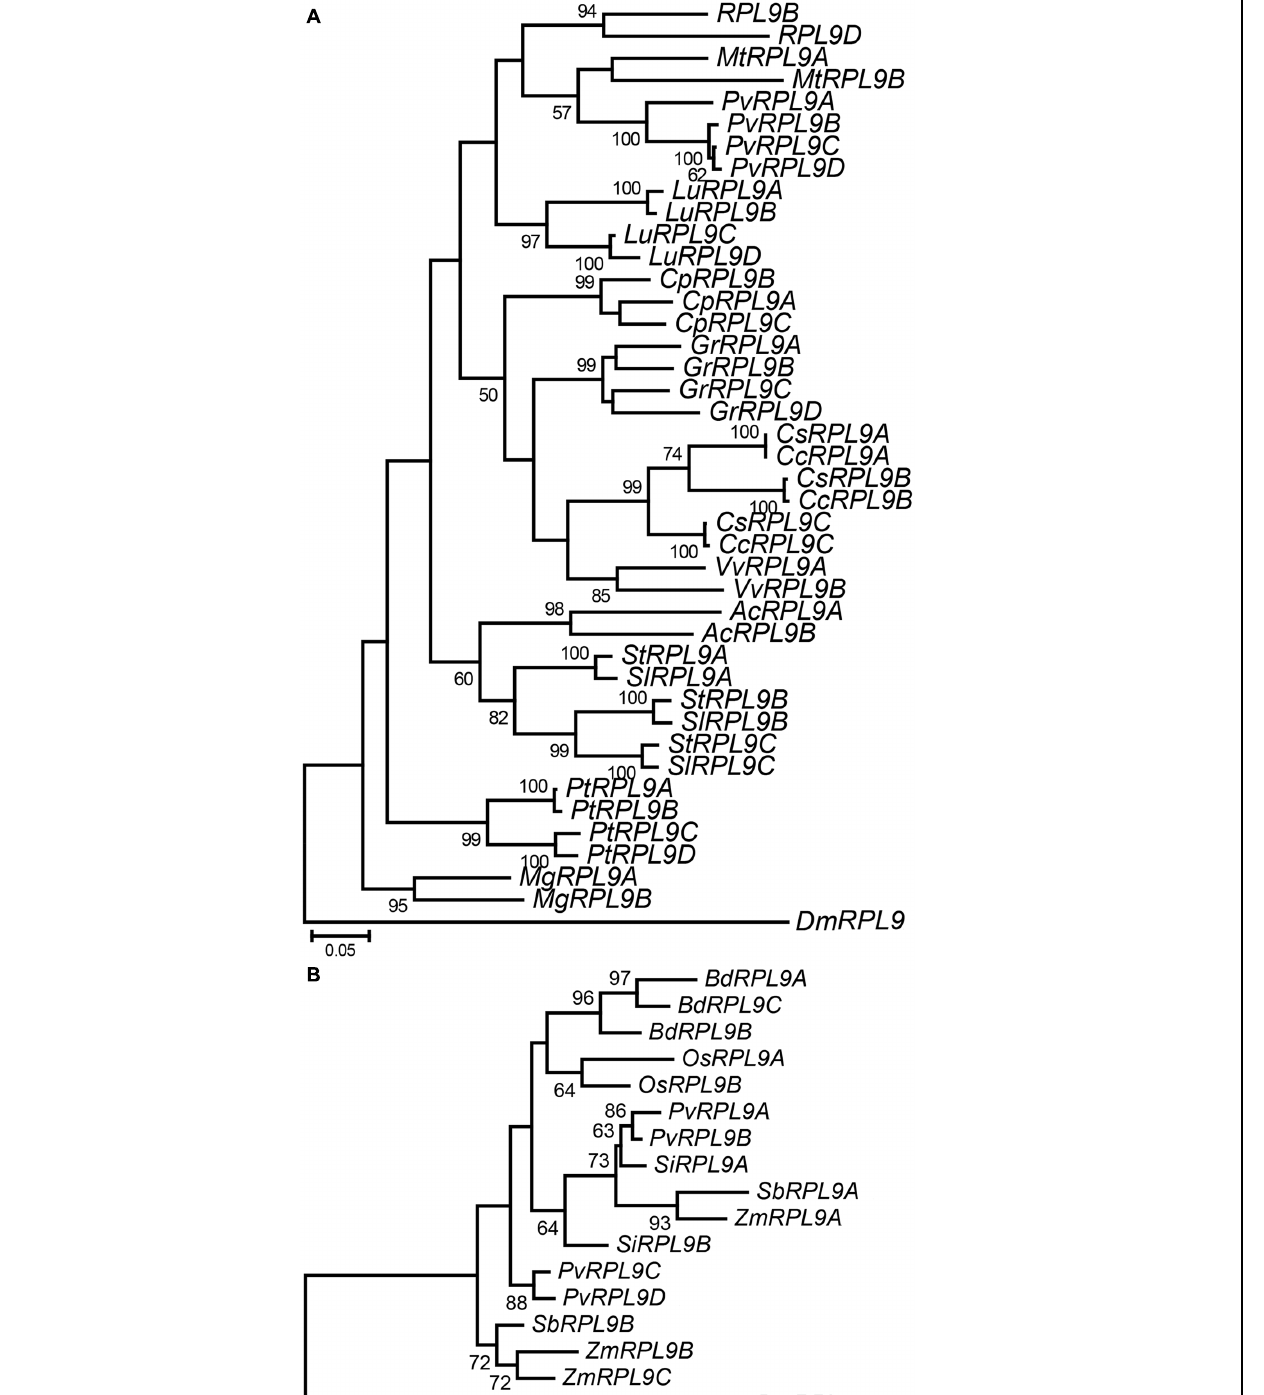
Frontiers in Plant Science |